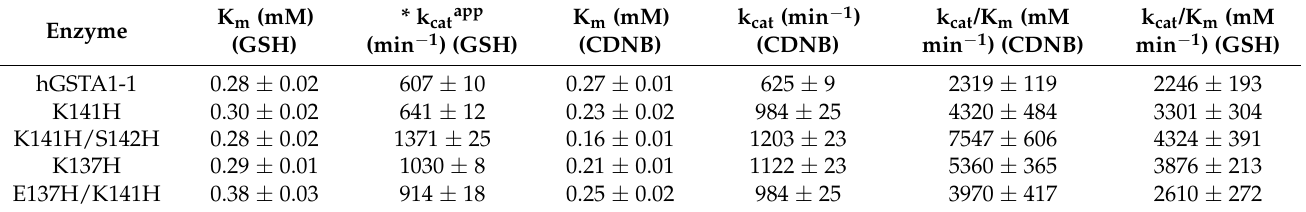
Table 2. The contribution of each mutation in the difference free energy change ( ∆ G) for stabilization of the transition state ( ∆∆